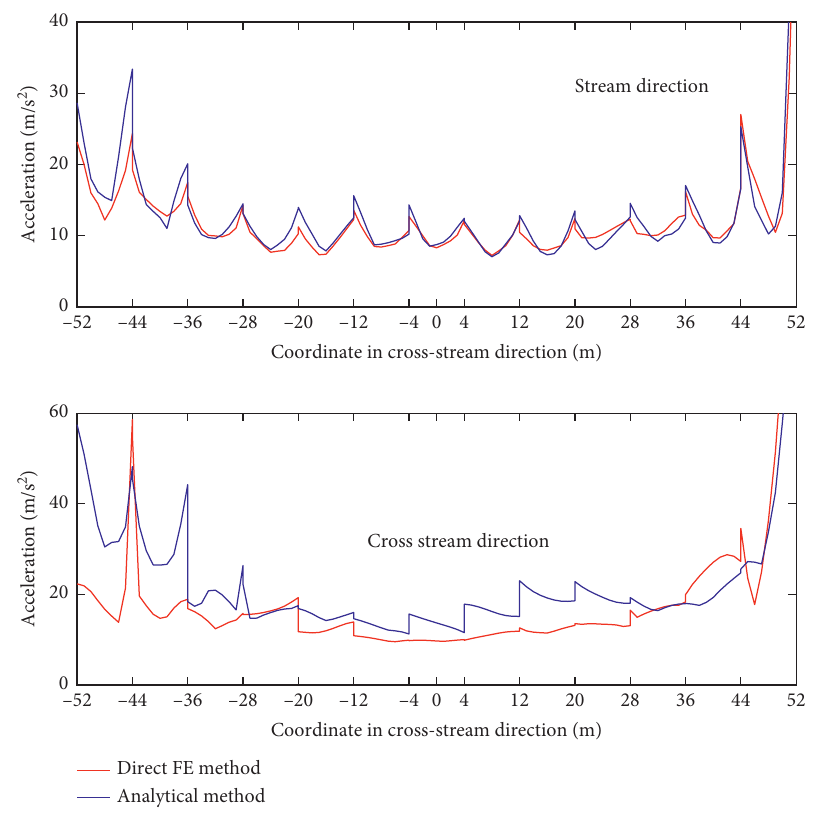
Figure 11: Distribution of PGA at upstream side of the buttress dam along the crest induced by the Swedish design earthquake in the (a) stream and (b) cross-stream directions for foundation modelling using direct FE method and analytical method.